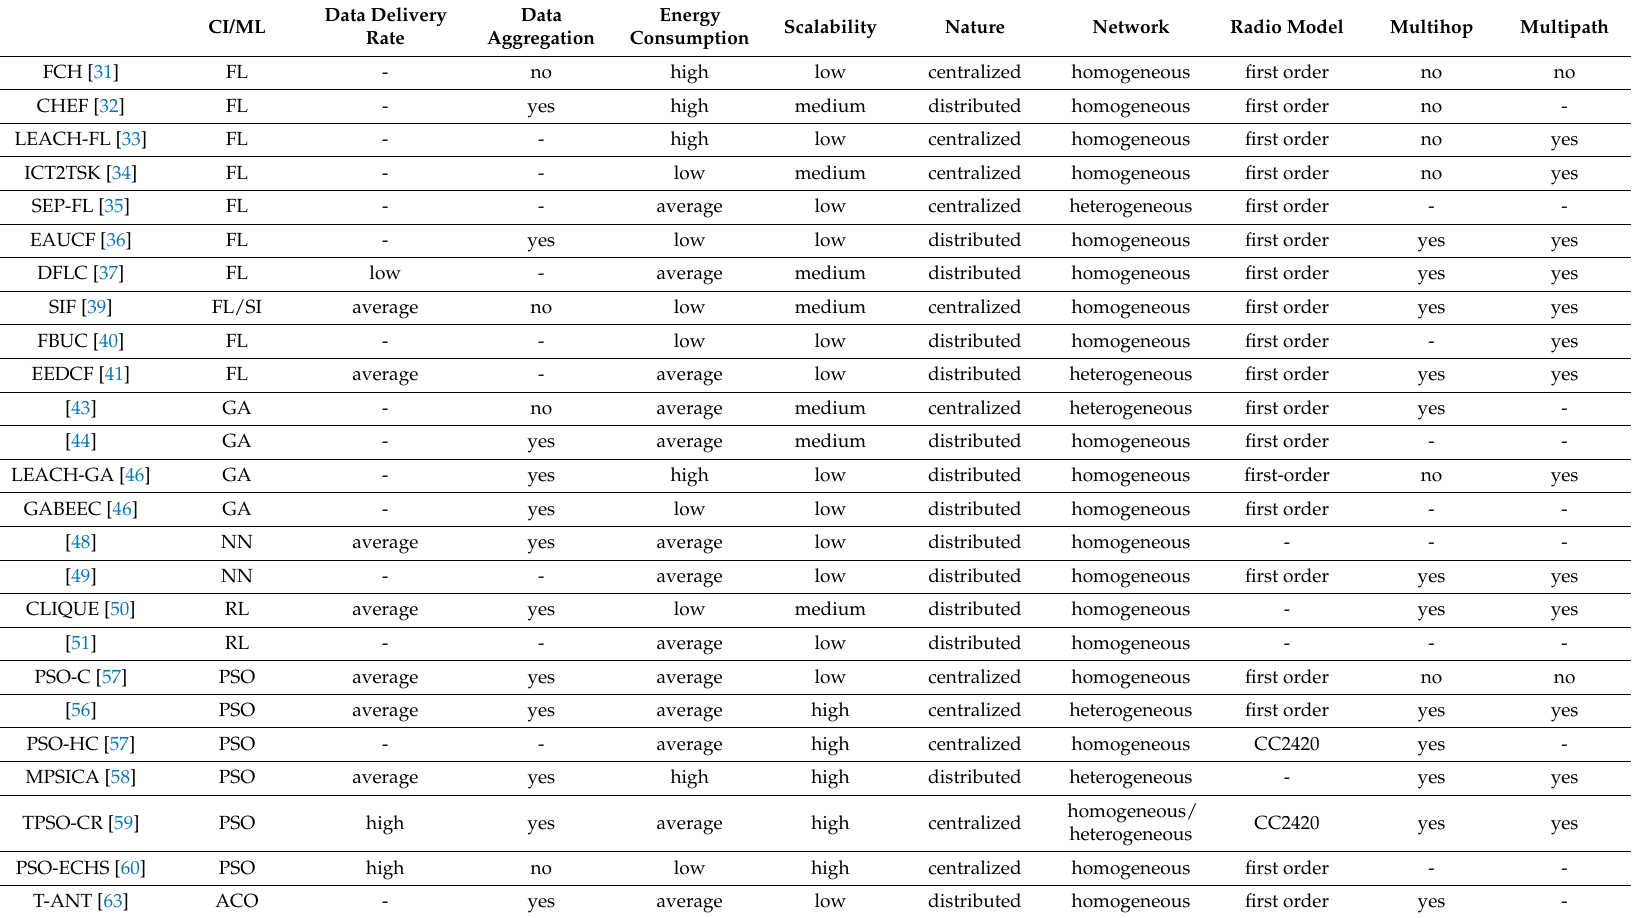
Table 7. Comparison of the optimized clustering